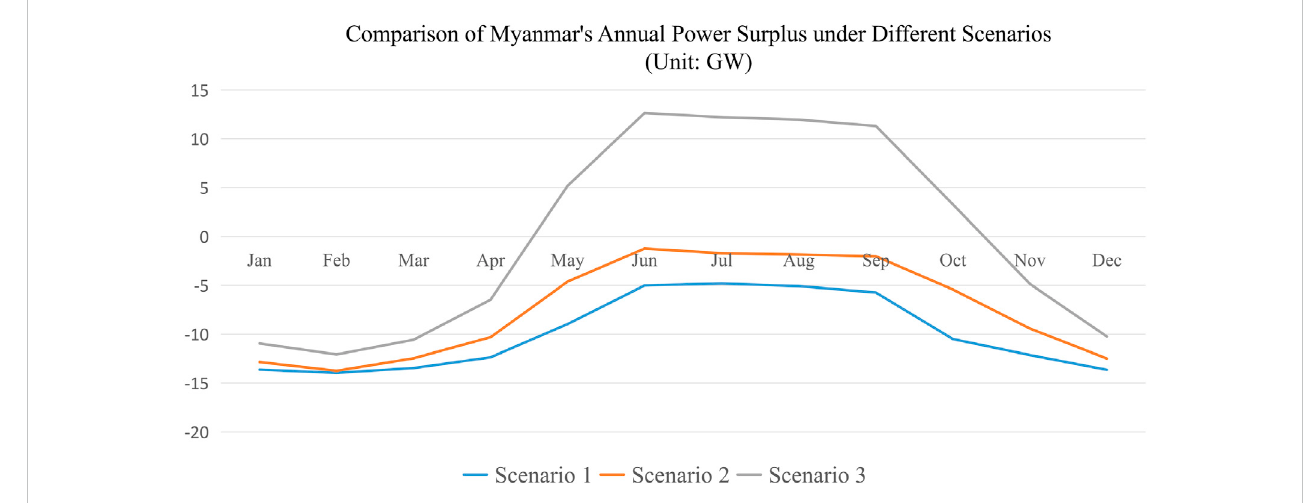
FIGURE 9 Comparison of Myanmar ’ s annual power surplus under different scenarios.